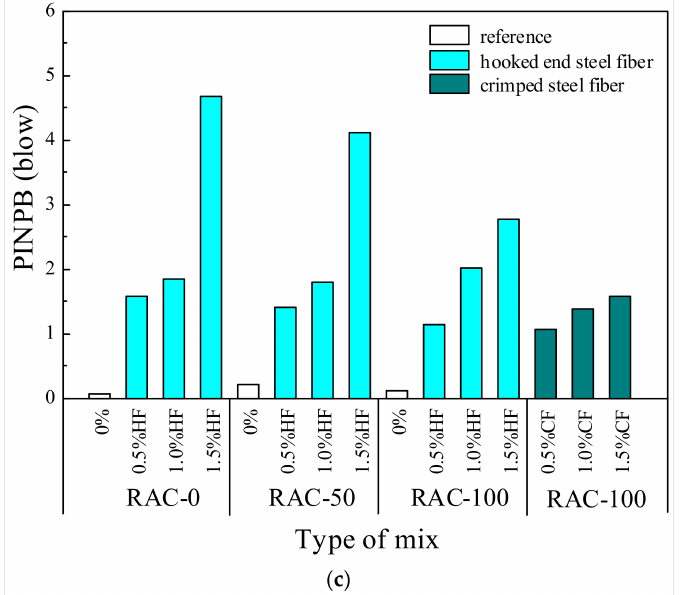
Figure 9. Test results of impact resistance: ( a ) the initial crack impact resistance; ( b ) the ultimate crack impact resistance; ( c ) The percentage increase in the number of post-initial-crack blows until failure.